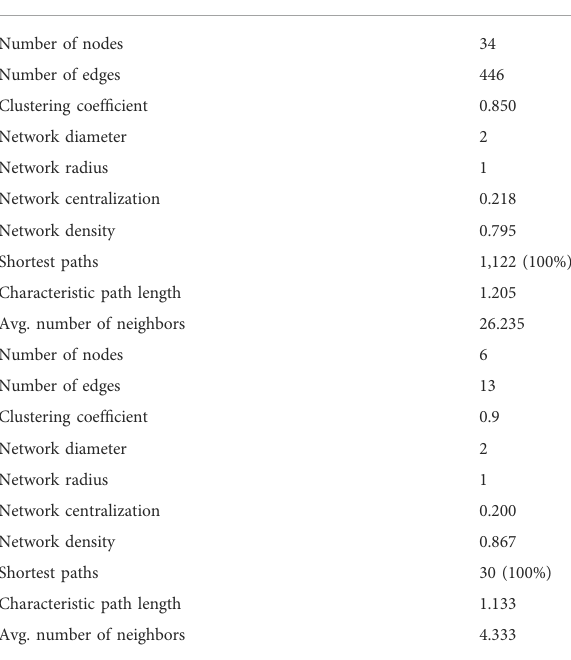
TABLE 3 The cluster network parameters of mulberry ( Morus alba L.) leaf fl avonoids and Ramulus Mori